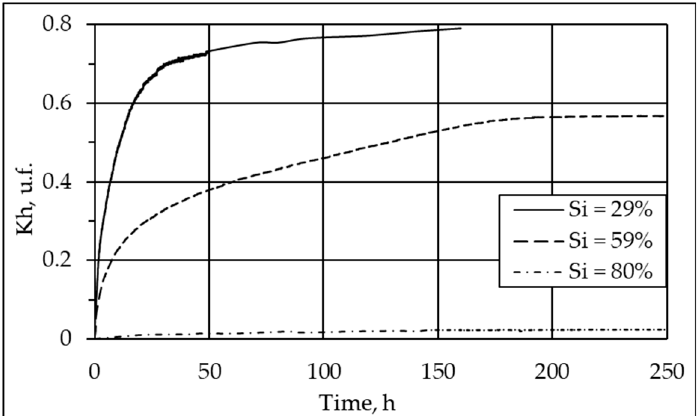
Figure 8. Time-dependent pore methane hydrate formation in silt 2 at different ice saturations ( Si ) (29, 59 and 80%) and at − 2.9 (cid:263) .